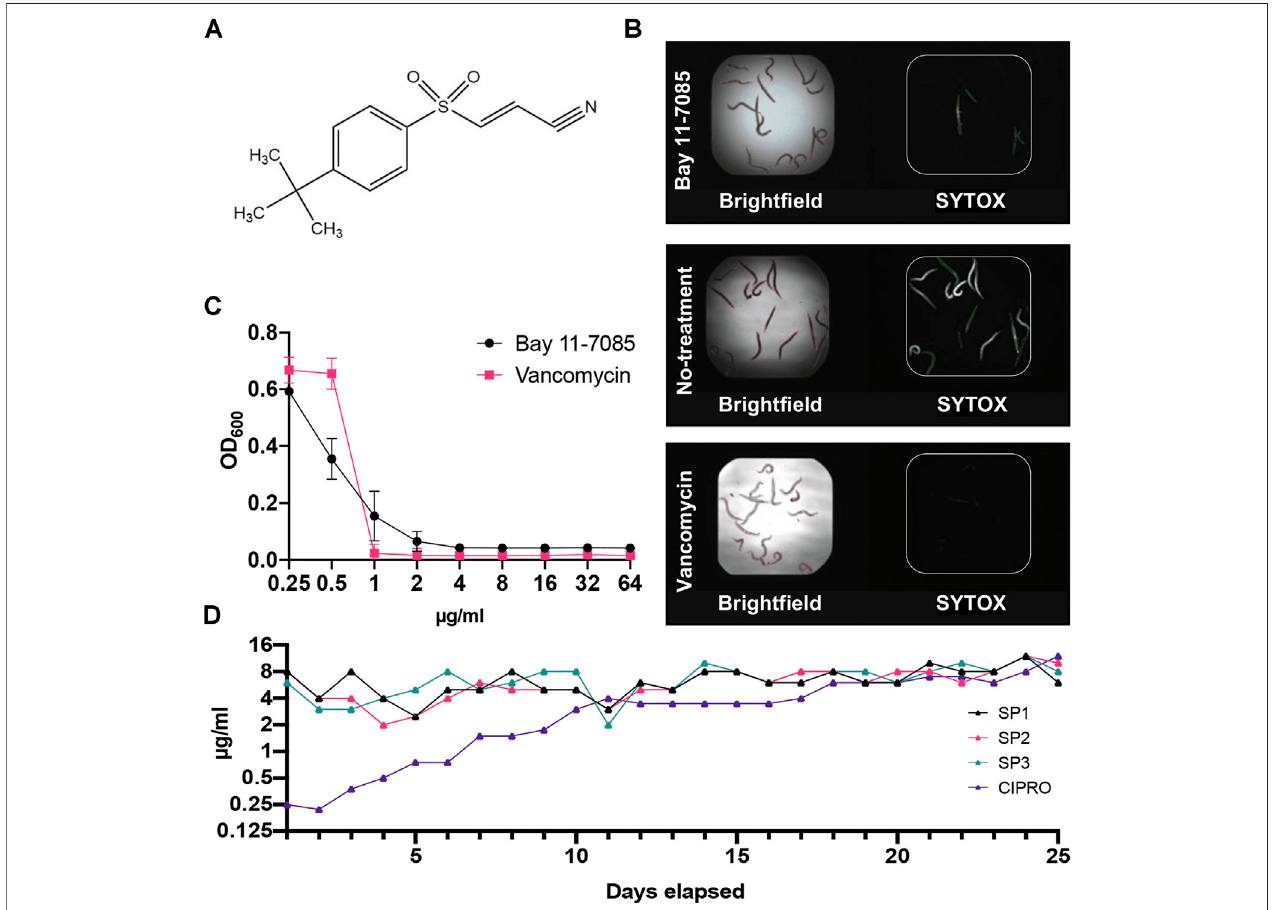
FIGURE1| Bay11-7085rescues C.elegans fromaMRSAinfectionandshowslowantibioticresistanceto S.aureus strainMW2. (A) ChemicalstructureofBay11- 7085. (B) Fifteen MRSA-infected C. elegans were treated with 7.14 μ g/ml Bay 11-7085, 0.1% dimethyl sulfoxide (DMSO) (no-treatment) or 10 μ g/ml vancomycin for 5 days. After staining dead worms with Sytox Orange, bright fi eld (left) and fl uorescence (right) images were obtained. (C) In vitro activity of Bay 11-7085 and antibiotic control vancomycin against MRSA strain MW2. Bacterial growth is quanti fi ed as a measure of OD 600 . (D) Three individual MRSA strain MW2 replicates (SP1-3) were serially passaged in increasing concentrations of Bay 11-7085 for 25 days. Passages with cipro fl oxacin (CIPRO) were conducted in parallel as a control.